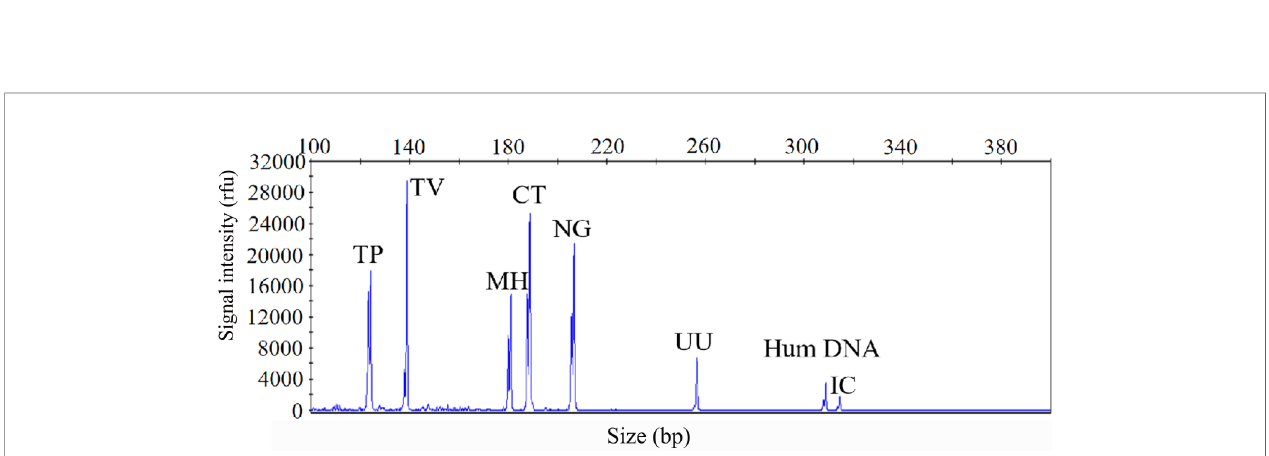
FIGURE 1 | The sexually transmitted infection high-throughput multiplex gene detection system (STI-HMGS) assay produced speci fi c ampli fi cation signals for 8 speci fi c targets. The X-axis indicates the actual PCR product size while the Y-axis indicates the signal intensity. (A-H) Assay results arising from the ampli fi cation of 6 STI pathogens and two control genes: Trichomonas vaginalis (TV), Treponema pallidum (TP), Chlamydia trachomatis (CT), Ureaplasma urealyticumm (UU), Neisseria gonorrhoeae (NG), Mycoplasma hominis (MH), human internal DNA control gene (Human DNA) and systematic internal control (IC), respectively. All target genes were speci fi cally ampli fi ed by the STI-HMGS assay without non-speci fi c ampli fi